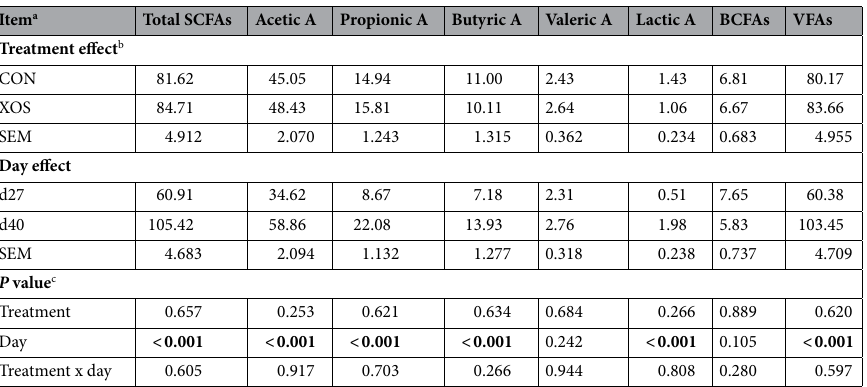
Table 3. Effect of XOS supplementation in total SCFAs concentration in feces, expressed in mM. Significant values are in bold. a SCFAs Short-chain fatty acids, BCFAs Branched-chain fatty acids, VFAs Volatile fatty acids. b CON Piglets supplemented with water, XOS Piglets supplemented with XOS. c P value obtained from ANOVA